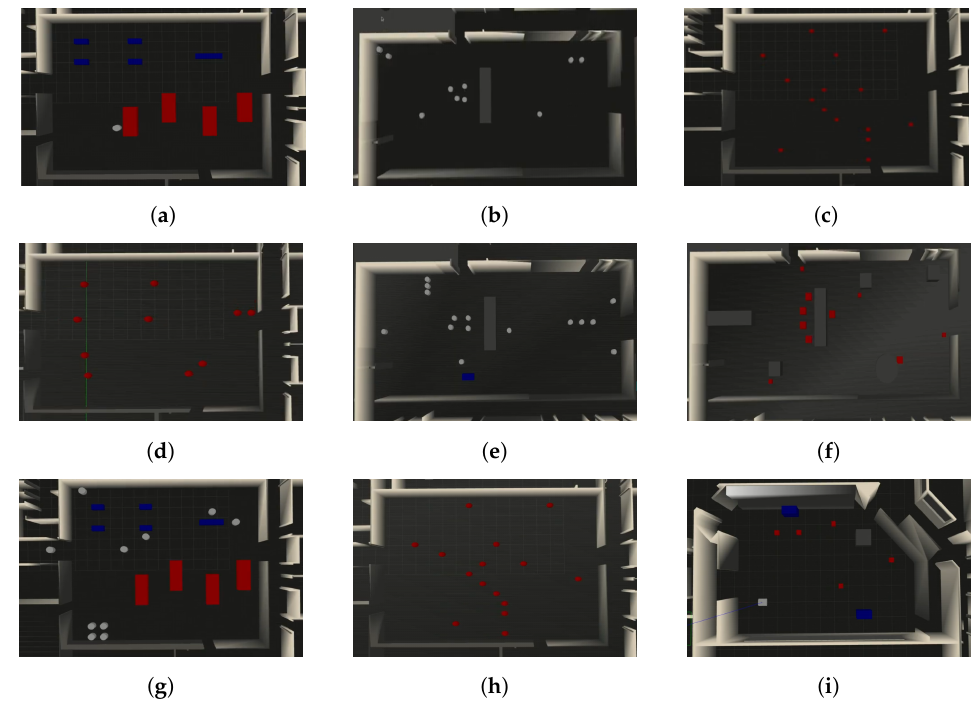
Figure 1. The nine stages selected using Tables 1 and 3. The captures are taken from Gazebo. The white and colored objects represent mobile and fixed obstacles. The full description of the nine stages can be found above, listed from ( a ) to ( i ). ( a ) Stage 1; ( b ) Stage 2; ( c ) Stage 3; ( d ) Stage 4; ( e ) Stage 5; ( f ) Stage 6; ( g ) Stage 7; ( h ) Stage 8; ( i ) Stage